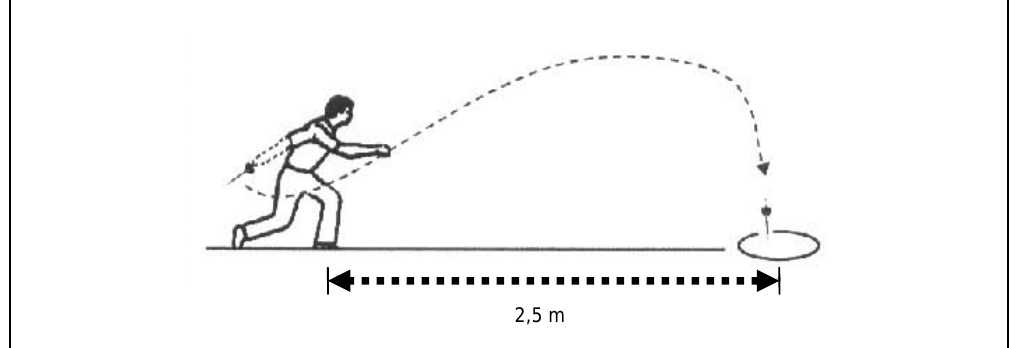
Figura 1. Desenho esquemático da tarefa de arremesso de dardo adaptada de Al-Abood, Davids e Bennett